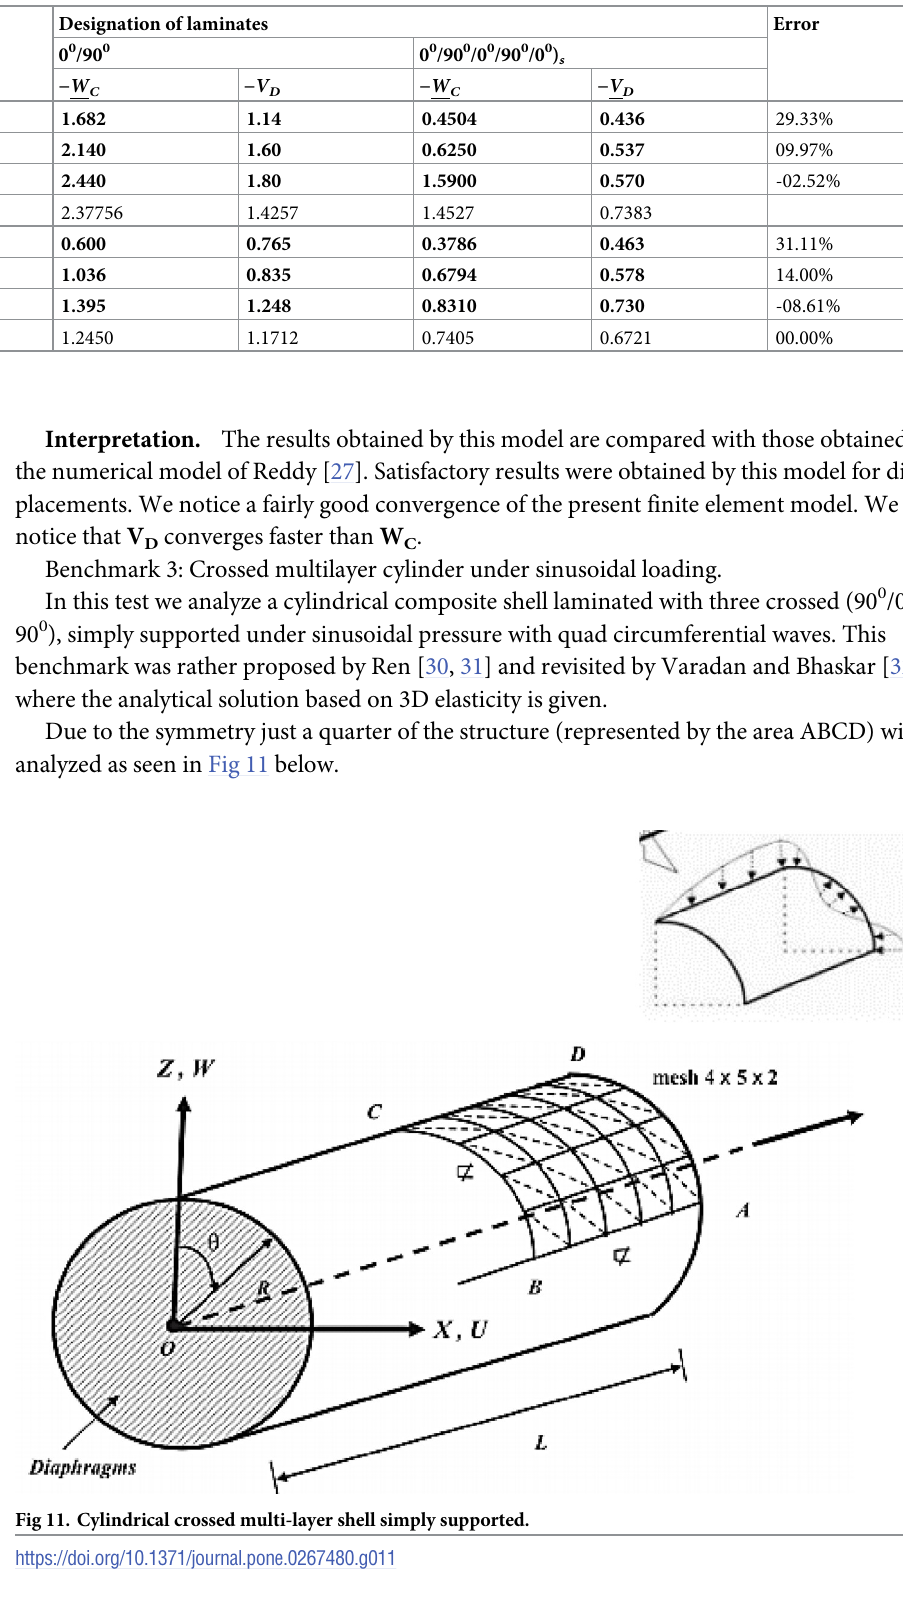
Table 2. Radial displacement W C and tangential displacement V D of the composite laminate shell clamped with diaphragms, Reddy [9].